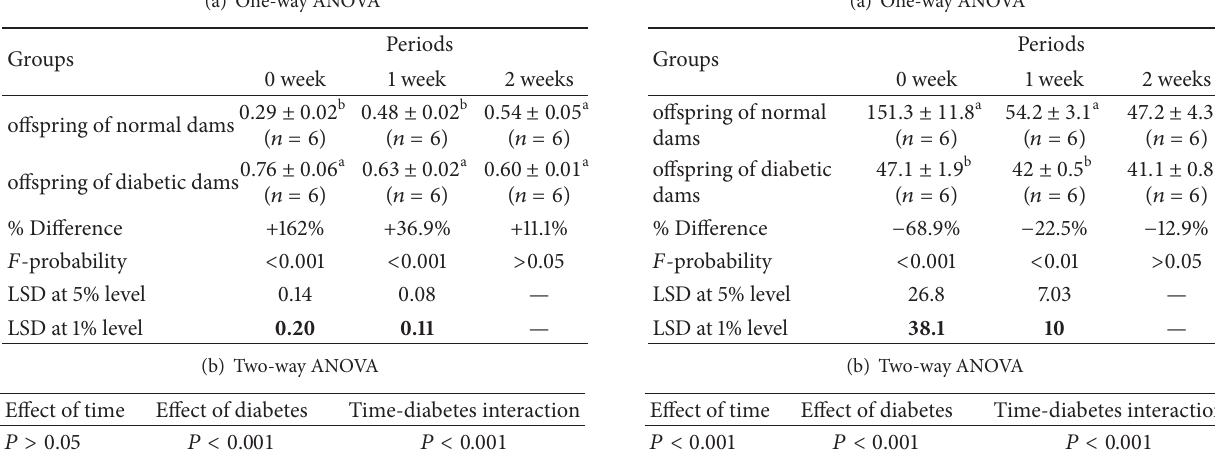
Table 3: HOMA-IR of offspring of normal and diabetic dams at different experimental periods.